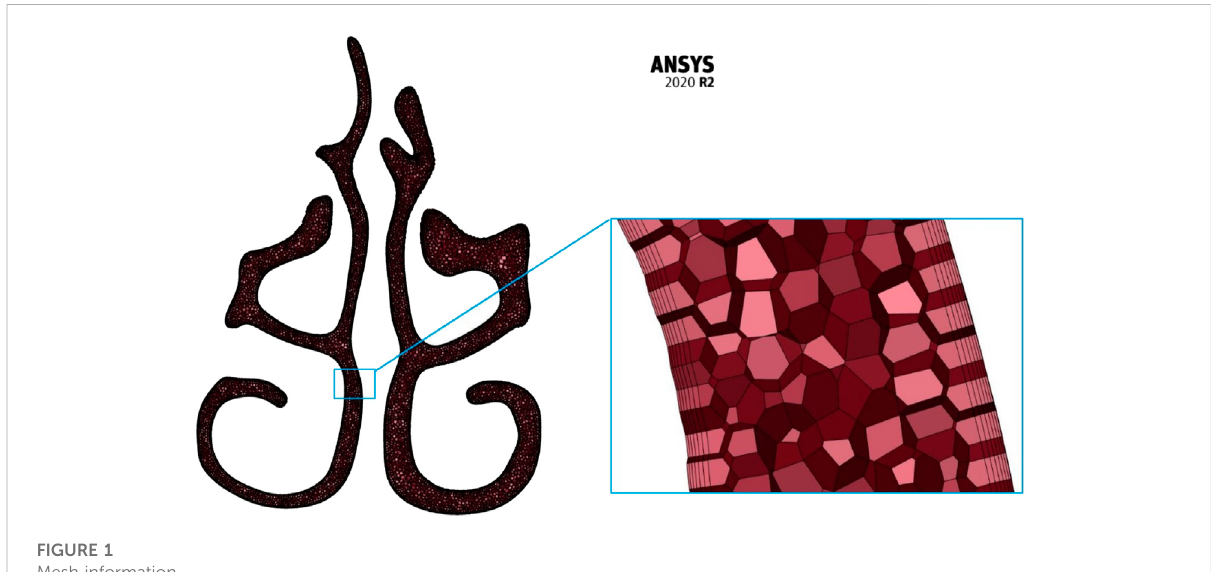
FIGURE 1 Mesh information.